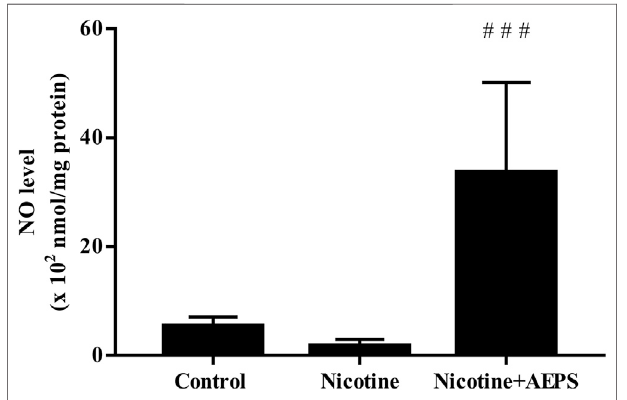
FIGURE 2 | Level of nitric oxide (NO) in rat aortic tissues. The values are given as mean ± SEM, n (cid:1) 6 – 8 for each group. ### p < 0.001 compared with the nicotine